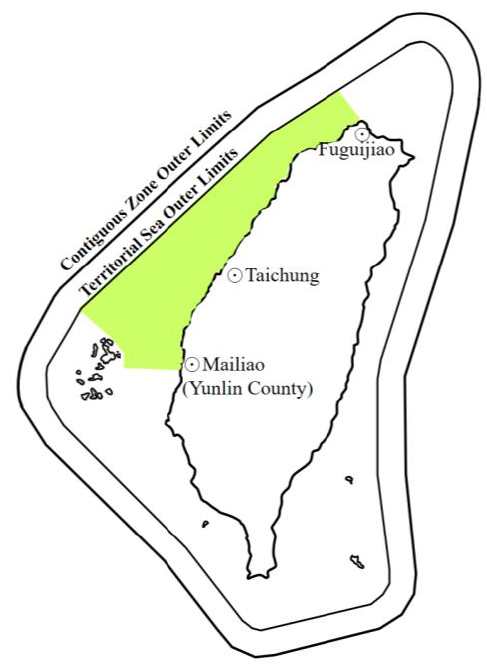
Figure 2. Schemed ocean regions marked in green for establishing offshore wind farm in the Taiwan Strait by 2035. Source: plotted by the